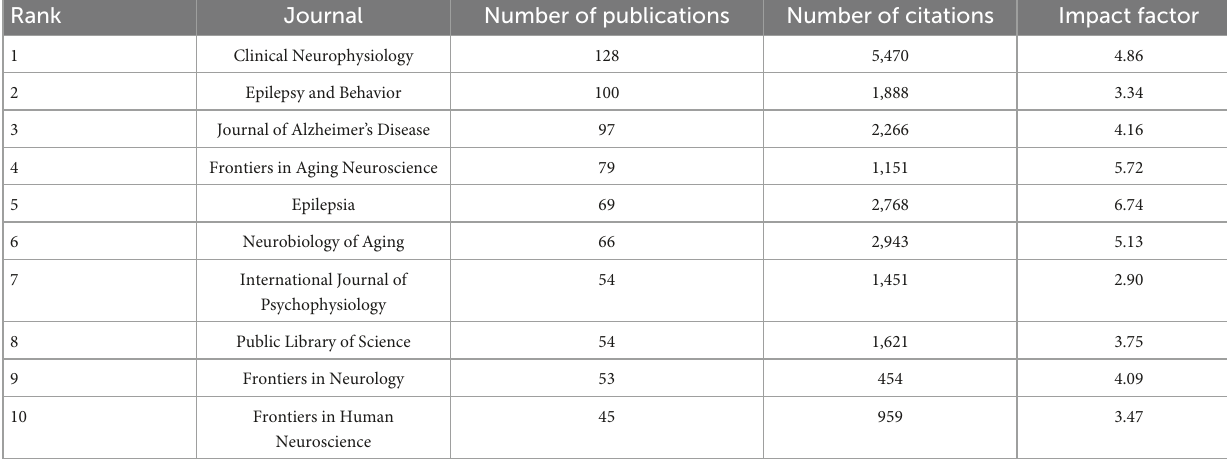
TABLE 3 Top 10 journals with most publications in the field of EEG for